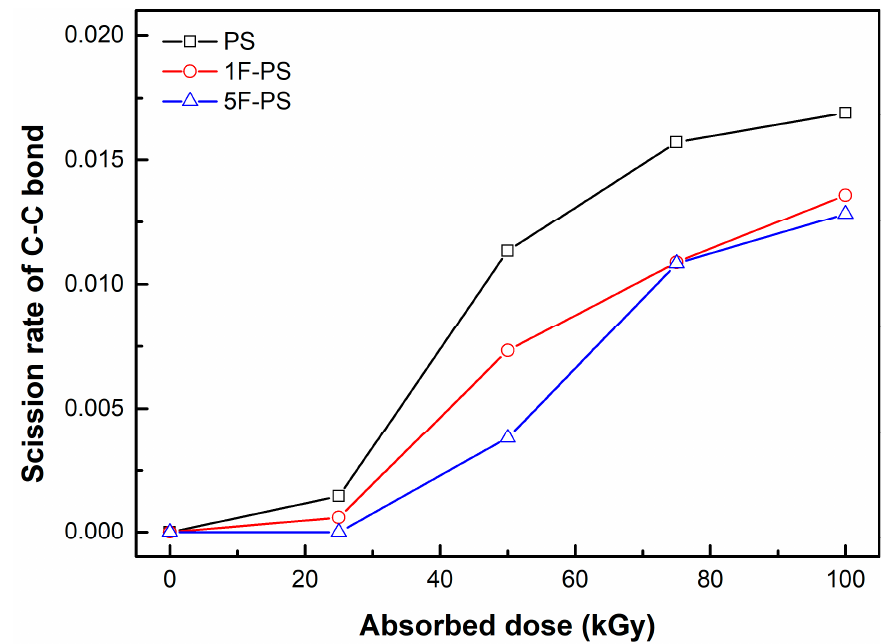
Figure 11. Scission rate of C-C bond of polymers.